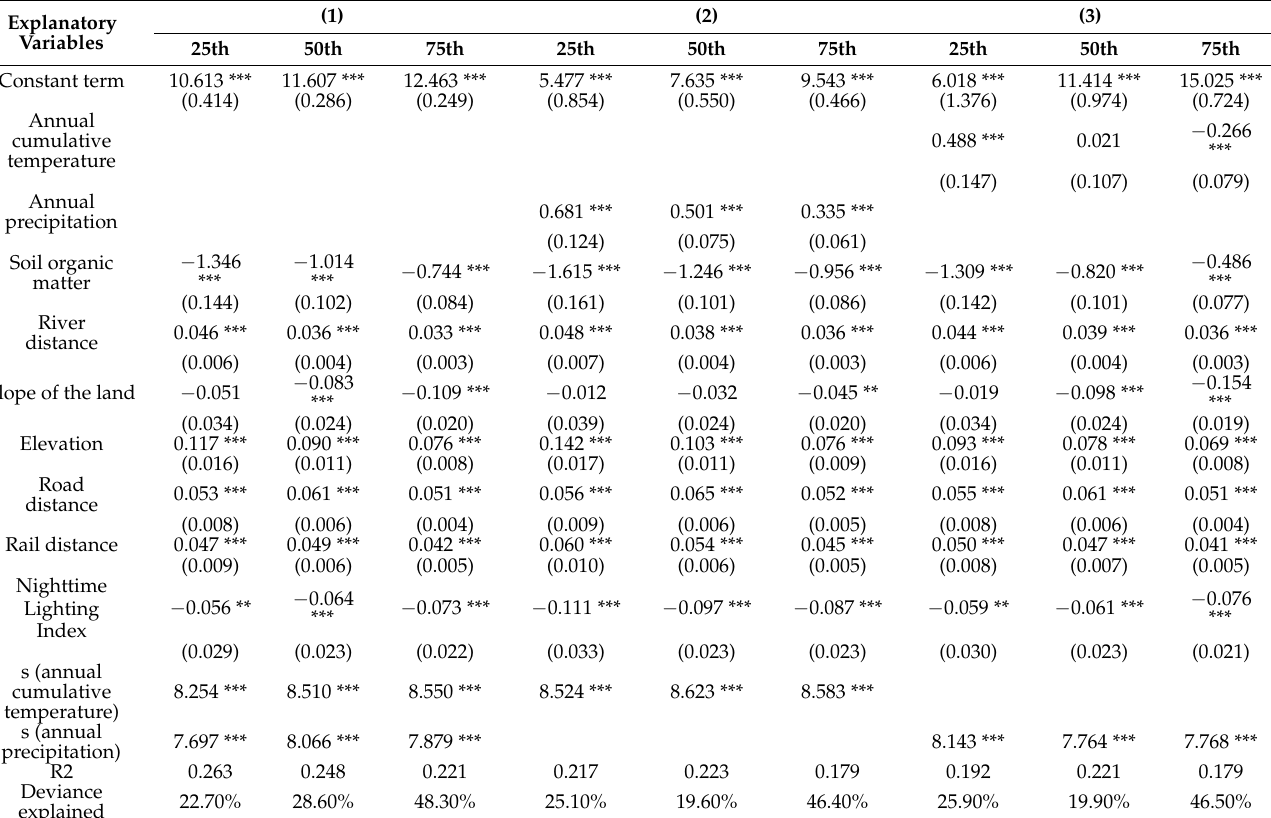
Table 4. Results of semi-parametric quantile regression for rice